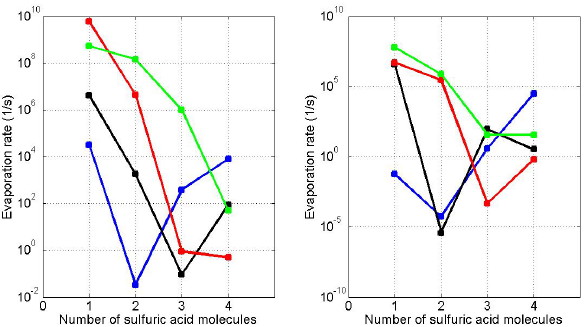
Fig. 4. Evaporation rates of different clusters versus number of sul- furic acid molecules in the cluster. The blue, black, red, and green lines represent clusters containing one, two, three, and four base molecules, respectively. The left panel is for ammonia clusters, while the right for those containing